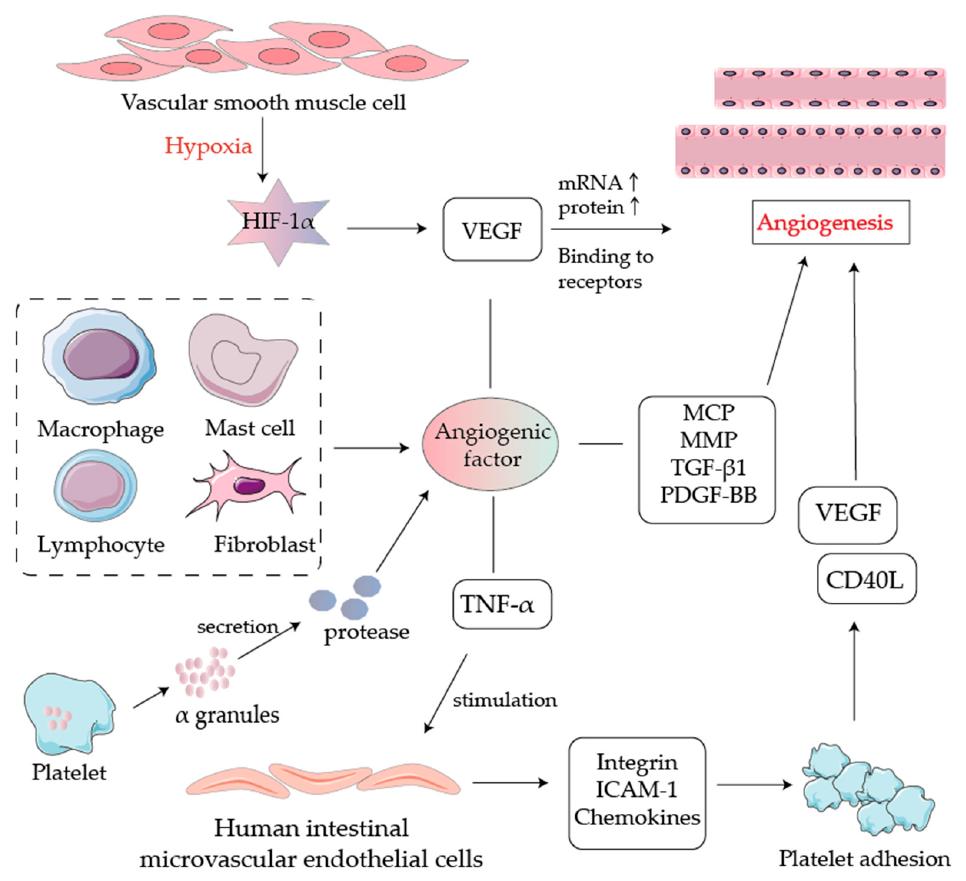
Figure 3. Regulation of angiogenesis.